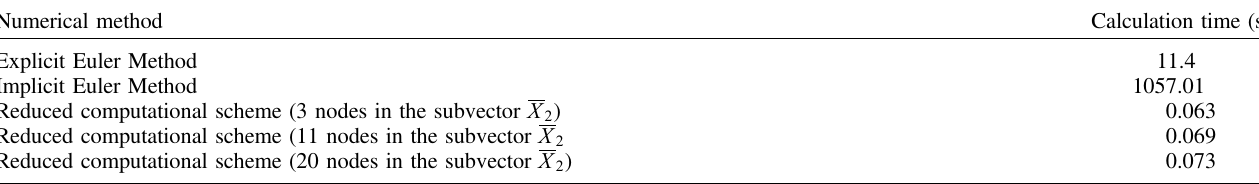
Table 2. Time for calculating EES by different methods.